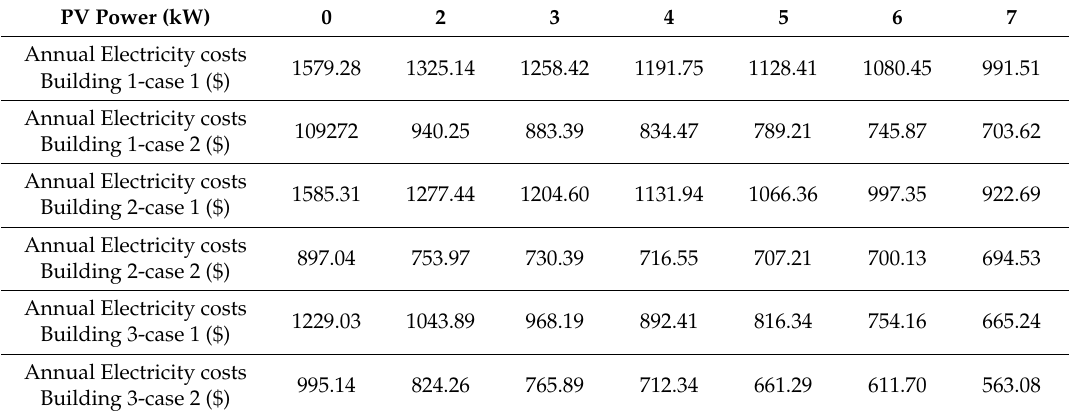
Table 6. Annual payment for different